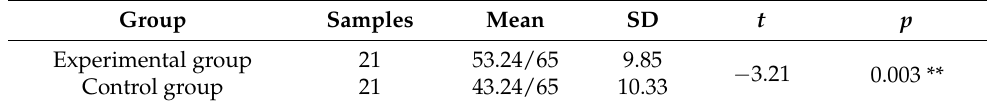
Table 8. Group means and results of independent sample t -test on learning motivation.